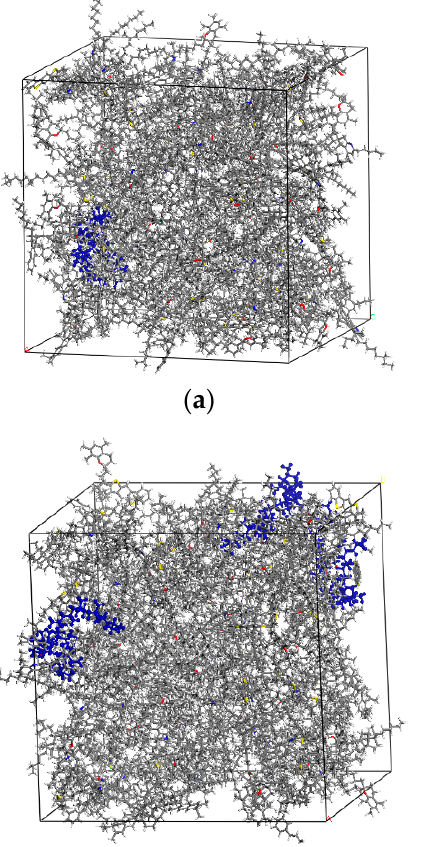
( b ) Figure 13. Model reasonableness verification. ( a ) Energy state of the model optimization process and ( b ) radial distribution function (RDF). Table 3 shows the densities of the asphalt models. The stable density of the base as- phalt model reached 0.964 g/cm 3 at 298 K and 1 standard atmospheric pressure, which is basically consistent with previous studies [36,37]. In addition, the density of the DM-mod- ified asphalt model is slightly smaller than that of the base asphalt, which is consistent with reality. In summary, the asphalt model constructed in this paper has a certain degree of reasonableness.